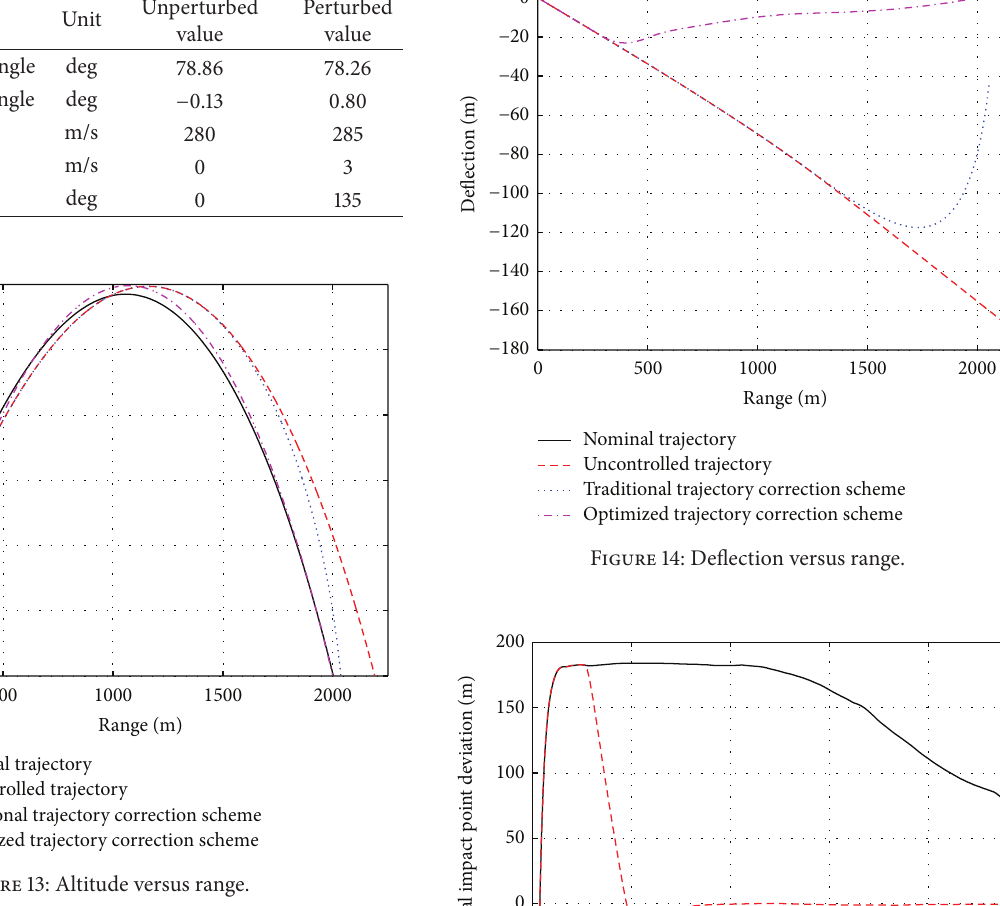
Figure 13: Altitude versus range.